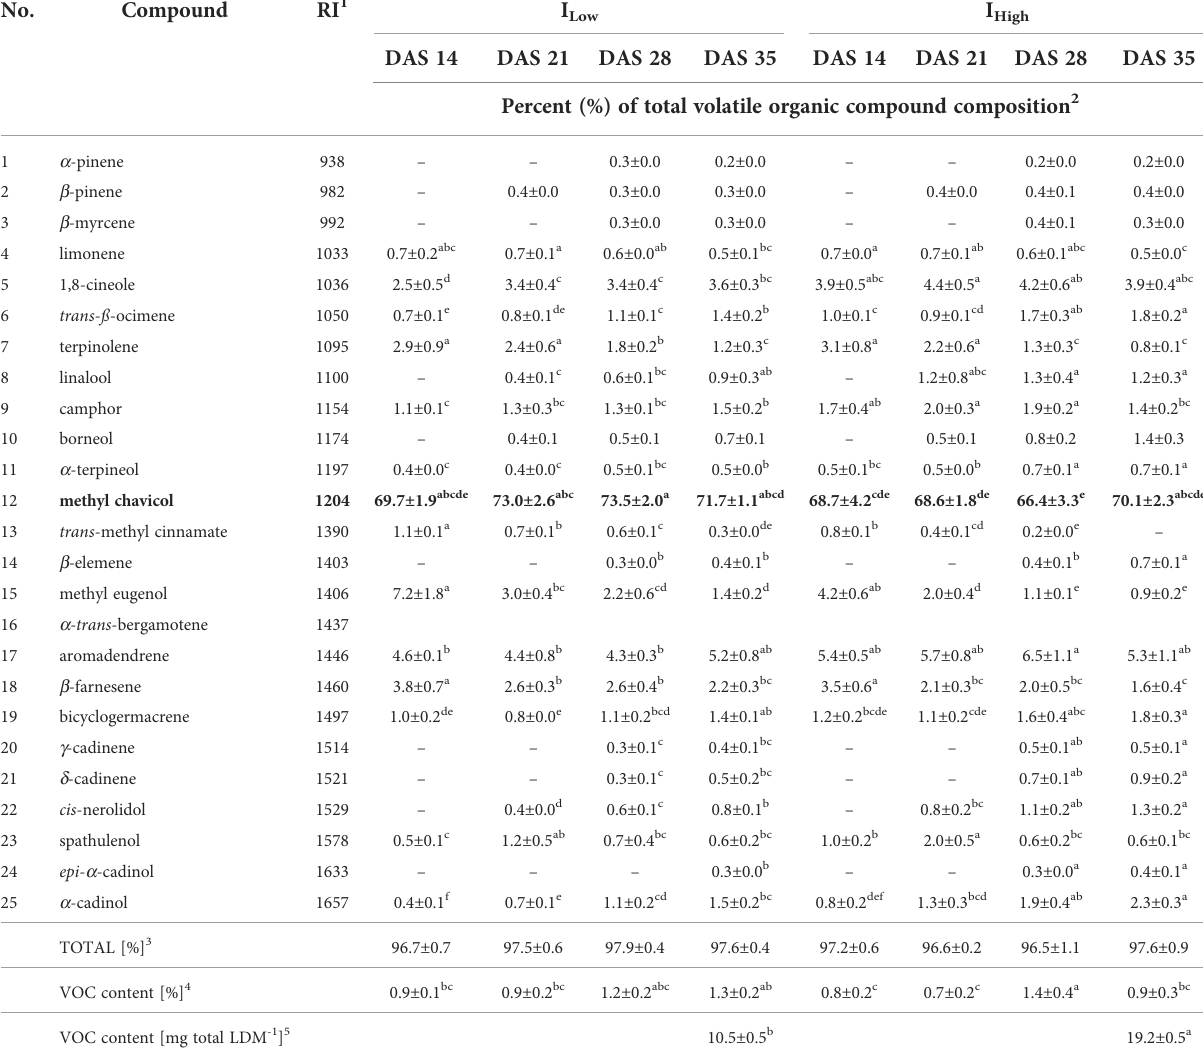
TABLE 5 Relative abundance of major volatile organic compounds identi fi ed in the leaves of O. basilicum L. cv. ‘ Thai Magic ’ as affected by LED light intensity treatments over time.